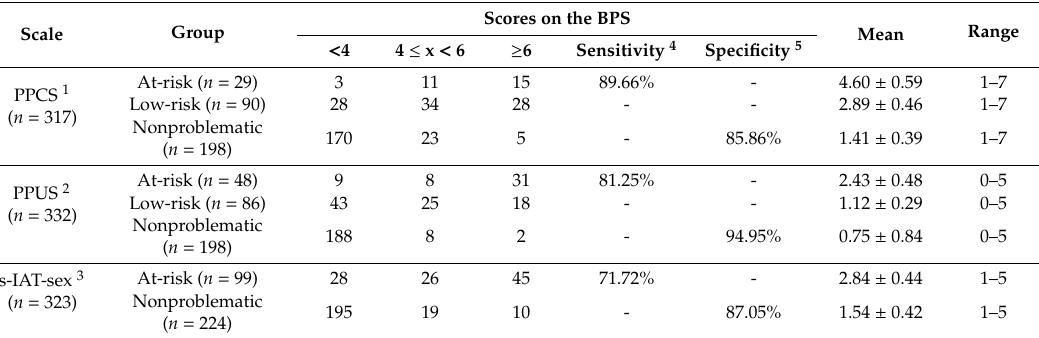
Table 4. Comparisons of the accuracy of the three